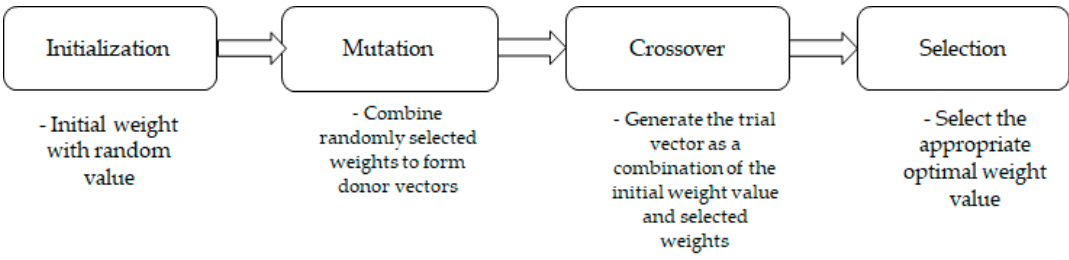
Figure 4. The flow of the differential evolution method.